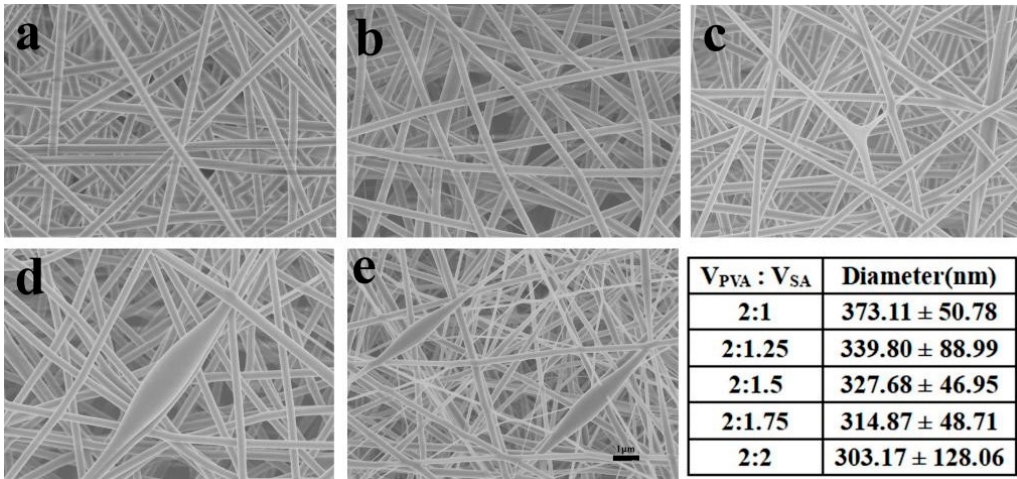
Figure 1. The morphologies and diameters of the poly(lactic acid) (PLA)fiber membranes, ( a ) 2%; ( b ) 4%; and ( c ) 6%.